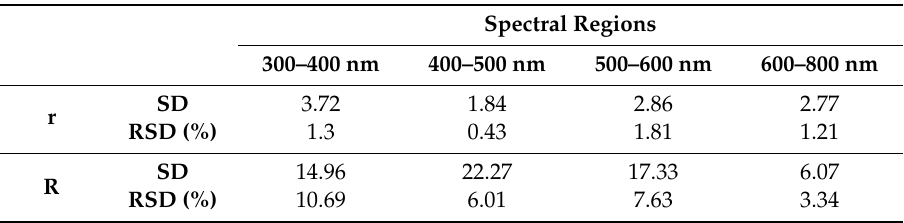
Table 1. Method repeatability (r) and internal reproducibility (R).